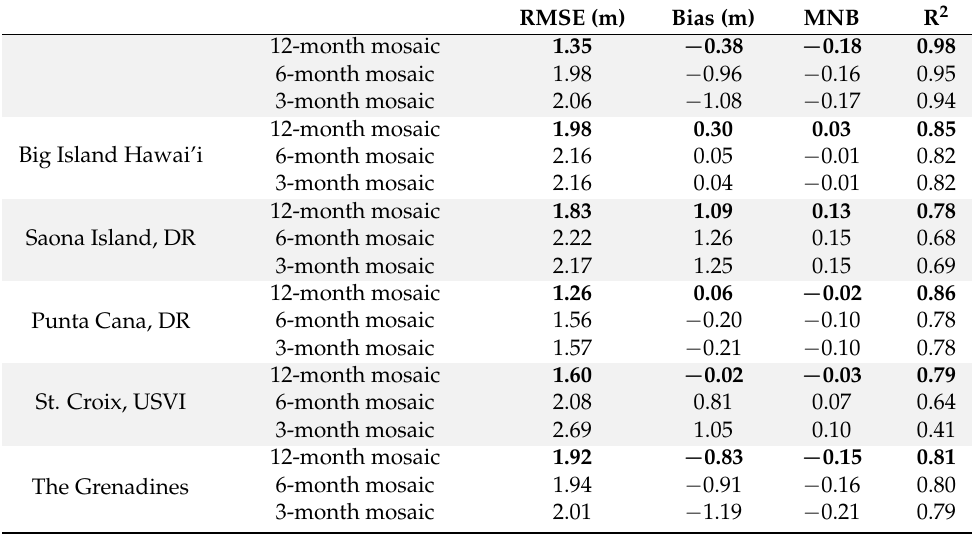
Table 2. Validation comparisons between different mosaic date ranges. Bold values represented the best estimation